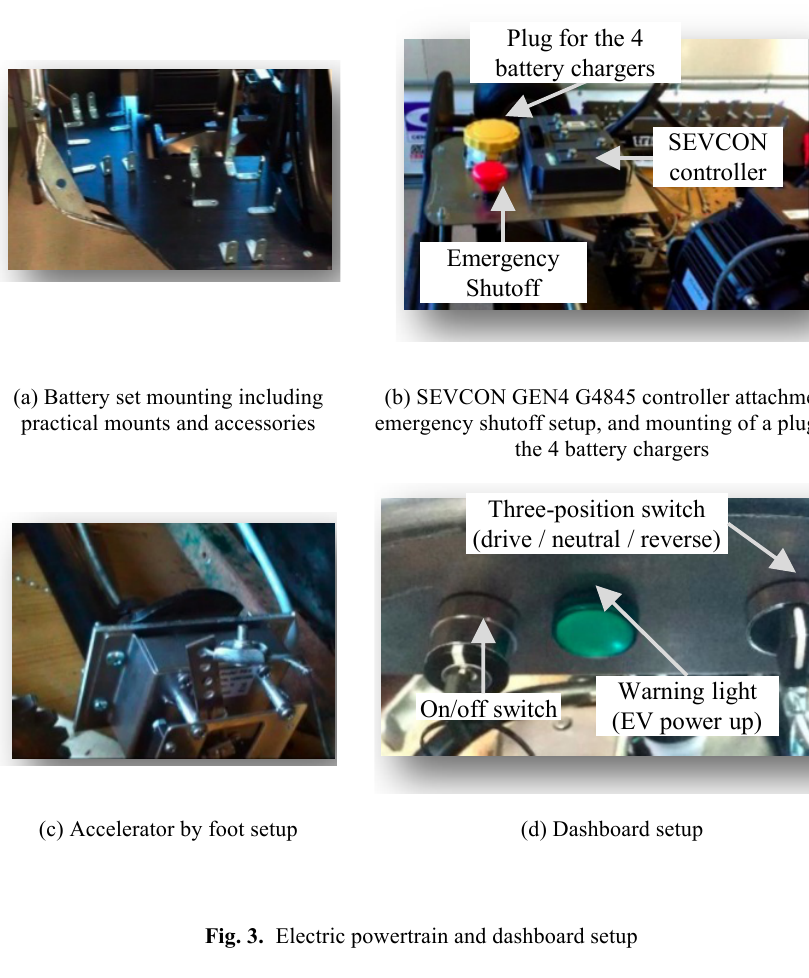
Fig. 3. Electric powertrain and dashboard